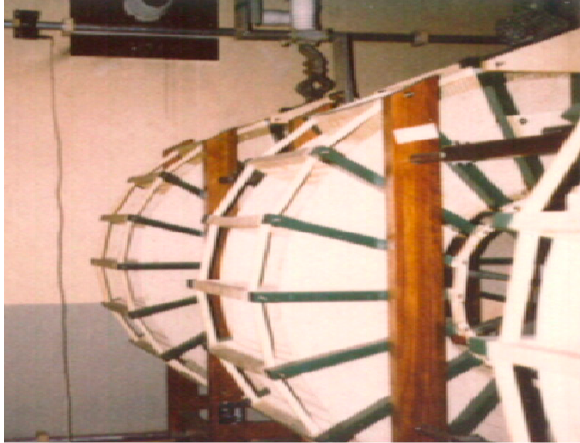
Figure 5. Three phase reactance in the power station “Folies”.